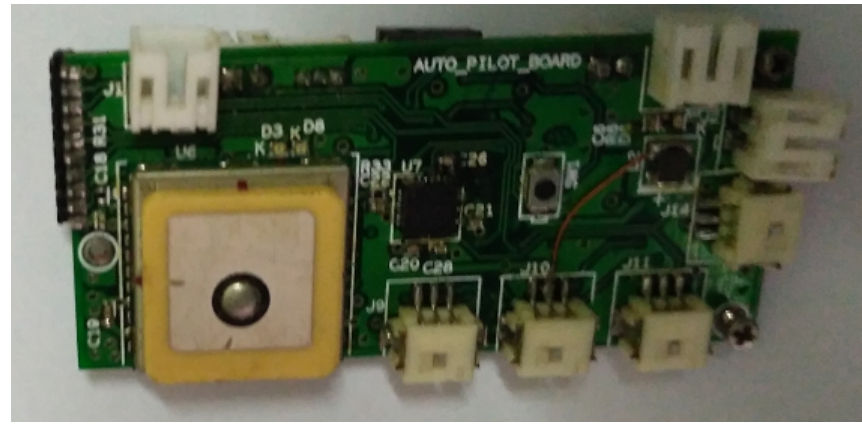
Figure 12. Autopilot hardware.